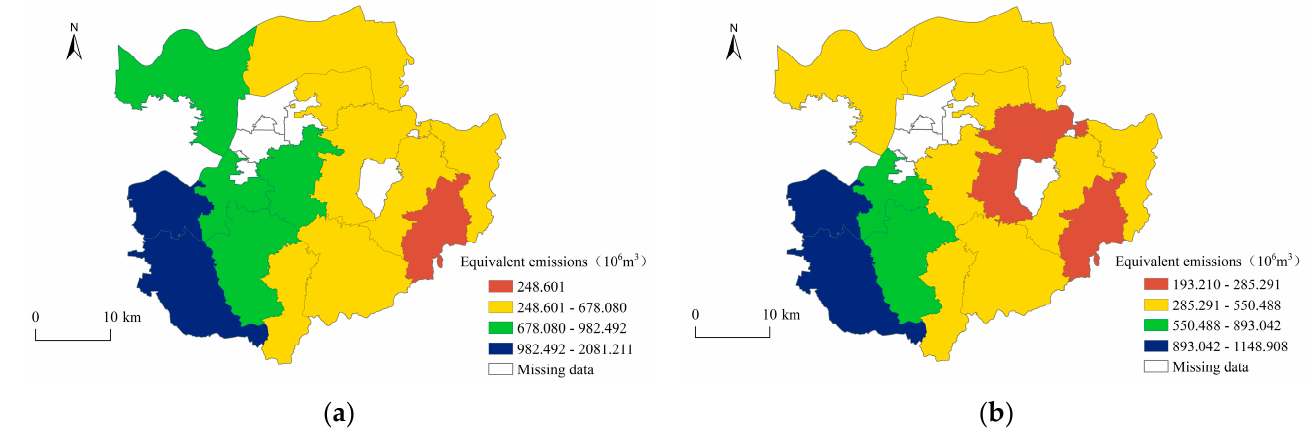
Figure 3. Spatial distribution of ANSP in Gongyi City: ( a ) 2002; ( b ) 2019.